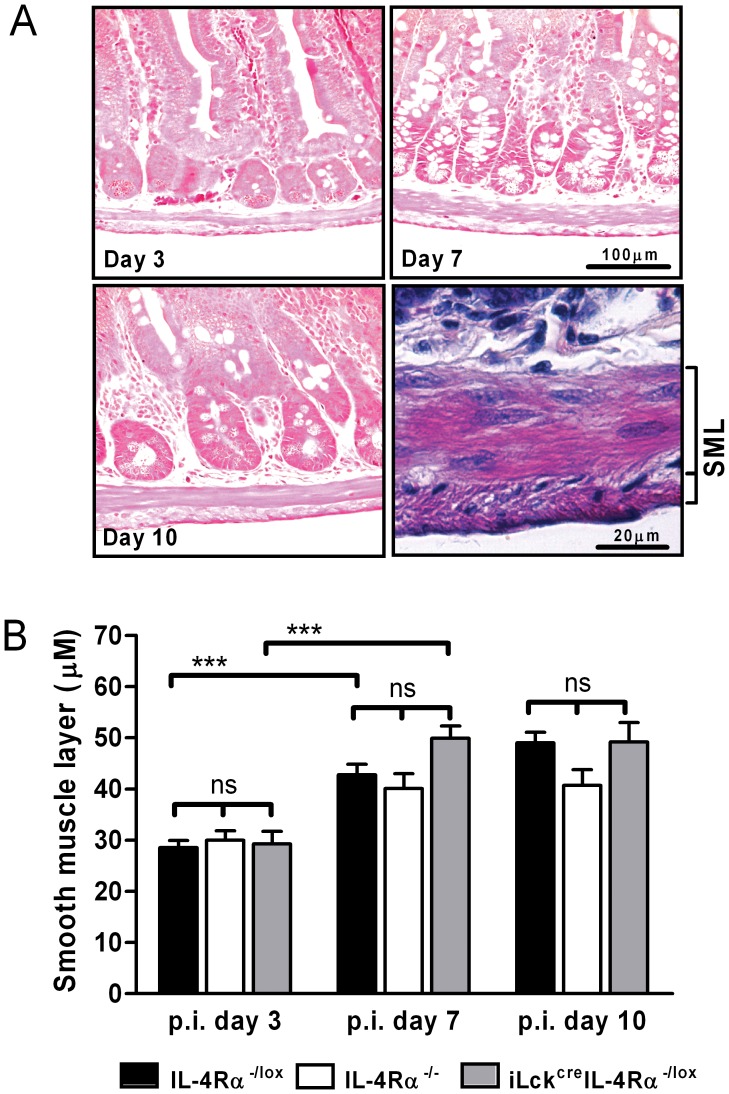

N. brasiliensis induced smooth muscle cell hypertrophy/hyperplasia is unaffected in iLckcreIL-4Rα−/lox mice.Haematoxylin and eosin stained sections were used to determine the smooth muscle cell layer thickness from Day 3, 7 and 10 N. brasiliensis-infected iLckcreIL-4Rα−/lox and control mice. Representative photomicrographs are shown from control mice at days 3, 7 and 10 at 40× magnification. Also shown is a photomicrograph at 200× showing the longitudinal and circular smooth muscle layers included in the measurement (A). Measurements are shown in a bar graph (B) with mean values+SEM and represent 2 independent experiments with n = 4 or 5 mice per group. Ns = not significant. One-Way-ANOVA, ***P<.001.